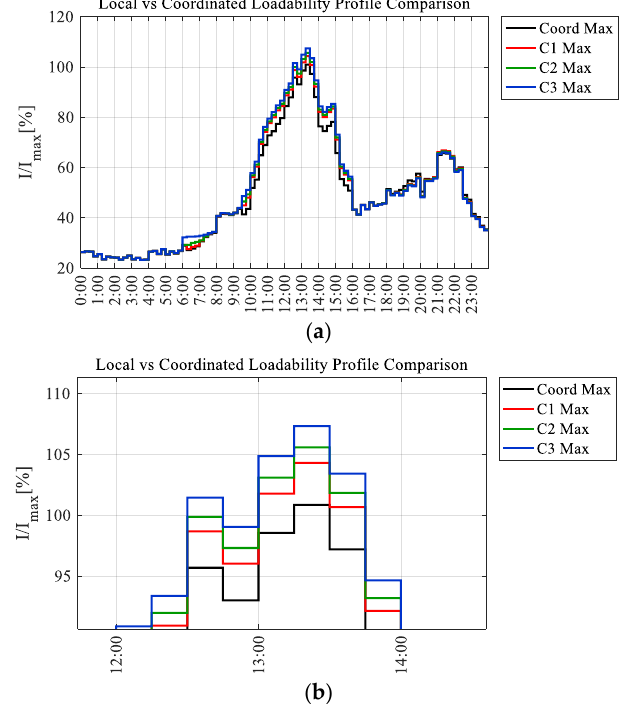
Figure 15. Local vs. Coordinated Control results: ( a ) DN’s loadability profile; ( b ) DN’s loadability profile (detail on photovoltaic peak hours). Energies 2020 , 13 , x FOR PEER REVIEW